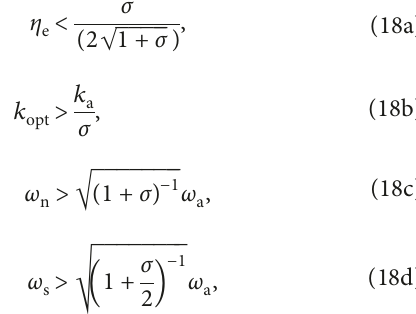
α 1 in which α min is determined by < <